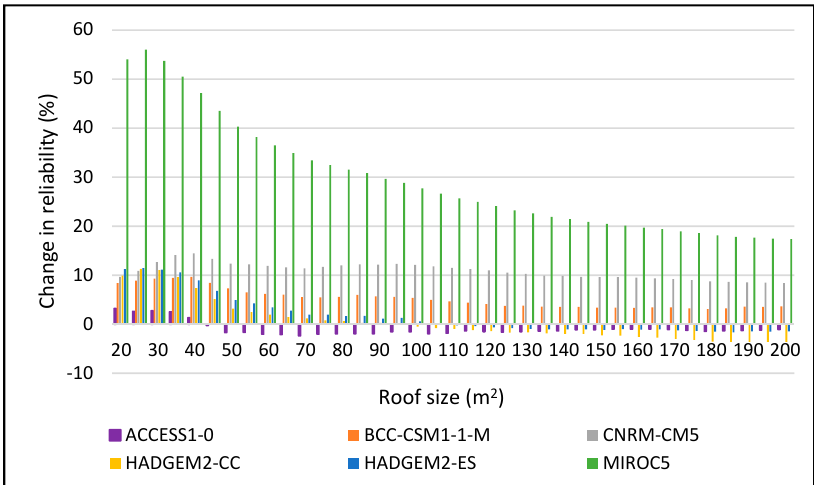
worst-case scenarios are predicted by MIROC5 and ACCESS1-0, respectively.